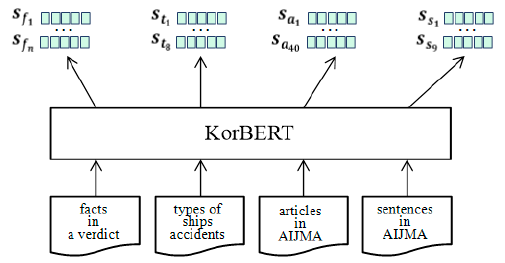
Figure 5. Framework of embedding layer.